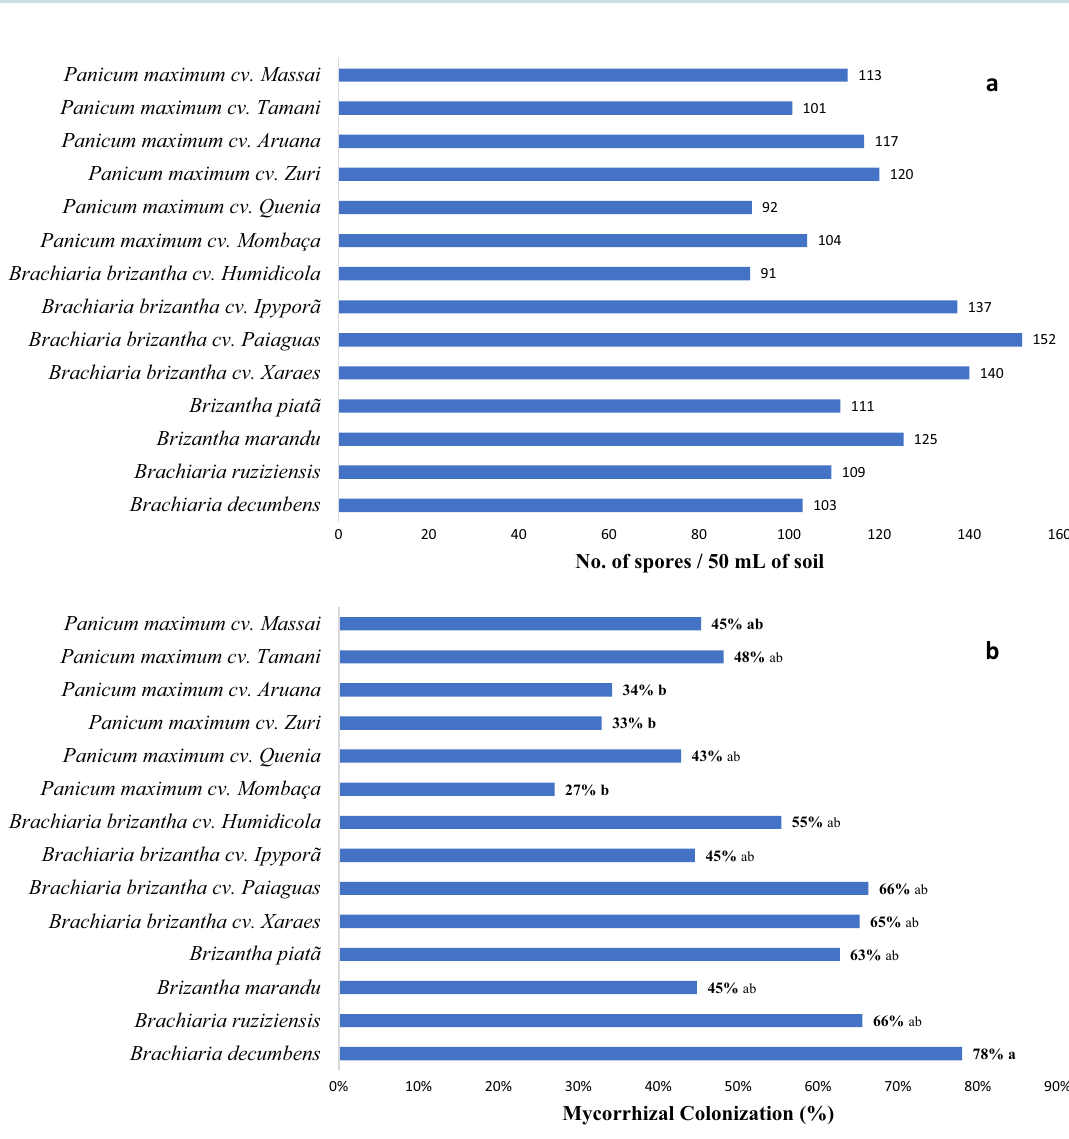
Figure 1. Density of mycorrhizal fungi spores in rhizospherical soil ( a ) and rate of mycorrhizal colonization ( b ) of different forage grasses in Cerrado